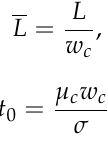
Figure 4. Droplet features with different disperse phase fractions in the cross-shaped junction. u total = 50 mm/s, t = 0.085 s.